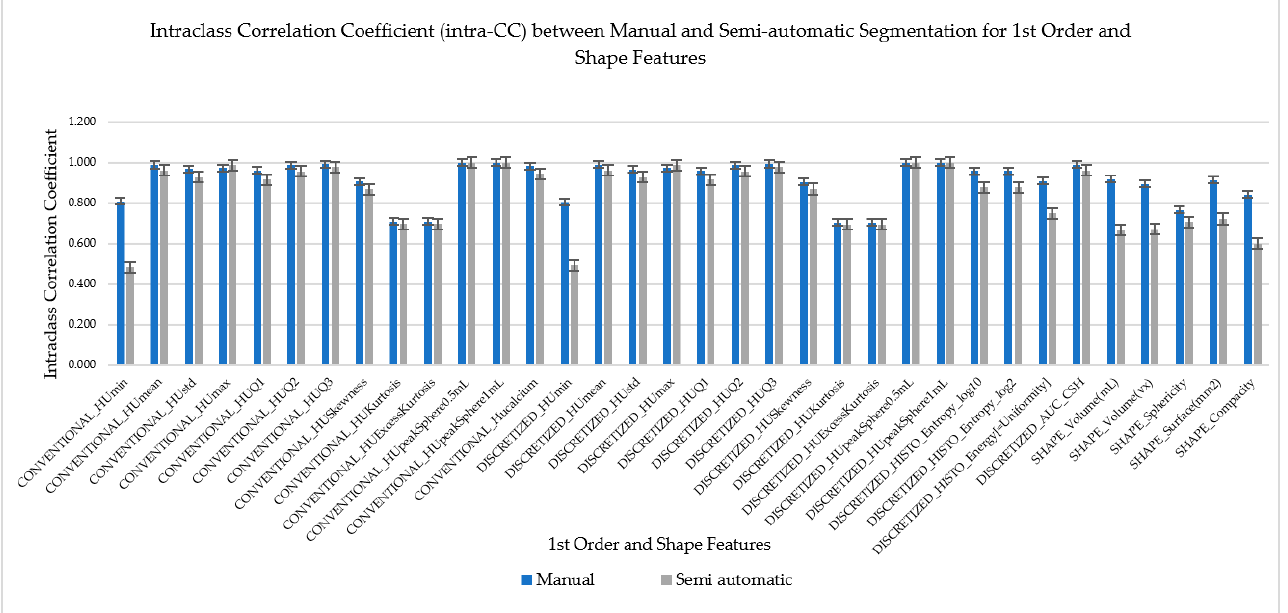
Figure 7. Intraclass Correlation Coefficient (intra-CC) between manual and semi-automatic segmen-